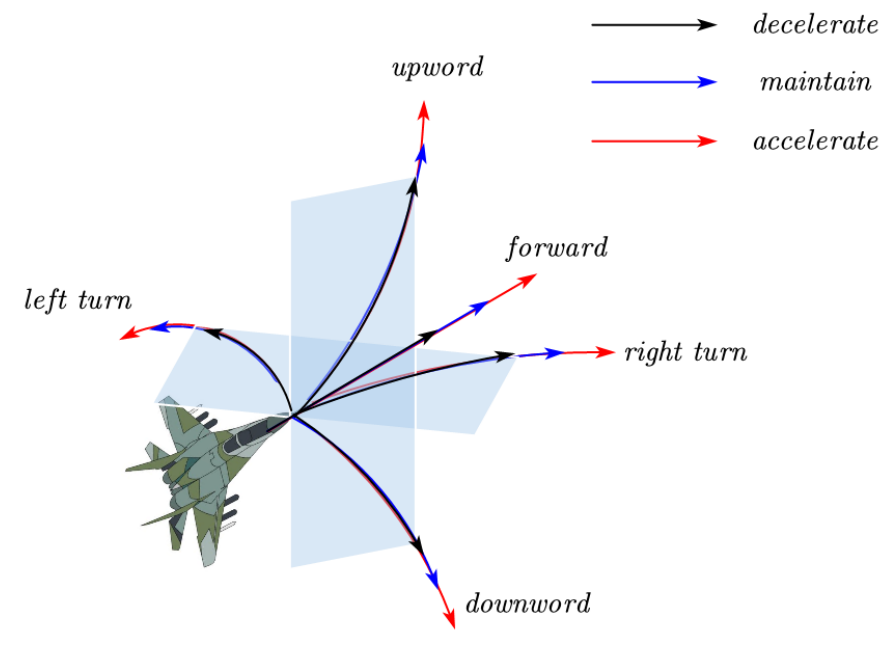
Figure 3. UAV maneuver